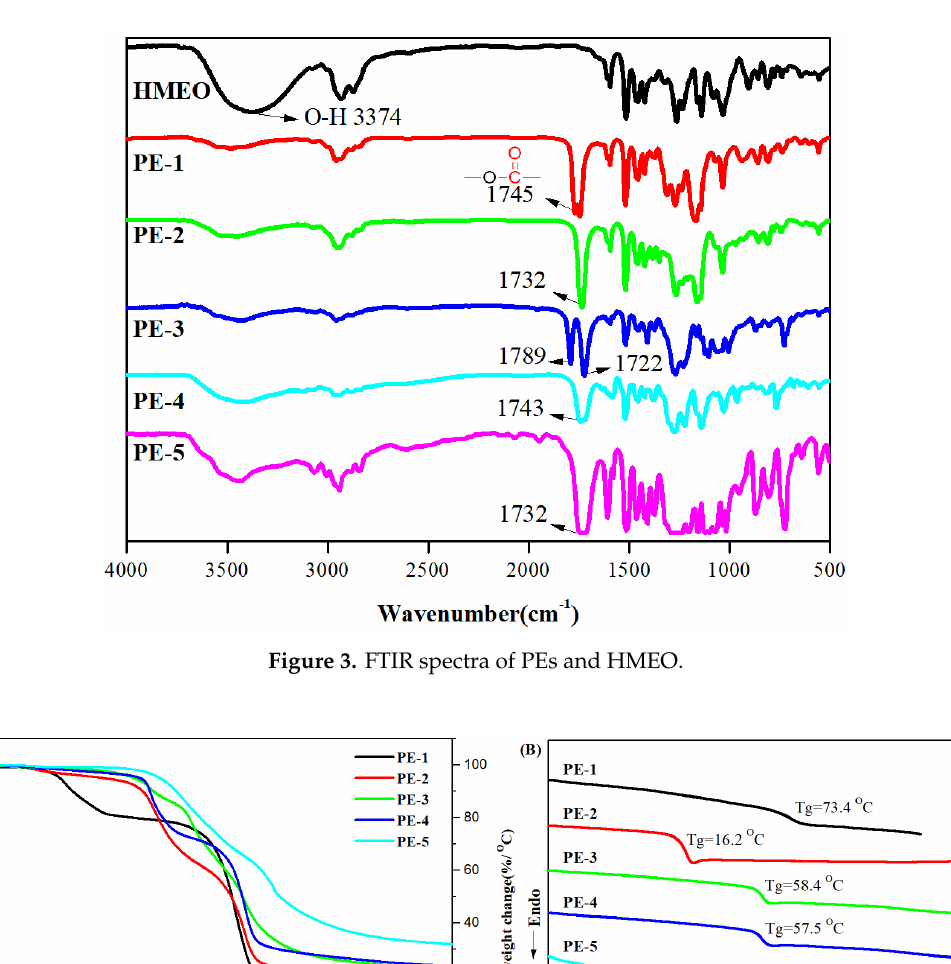
Table 1. Characterization of polyesters prepared from HMBO and vanillyl alcohol (VA) with a range of acyl chlorides .